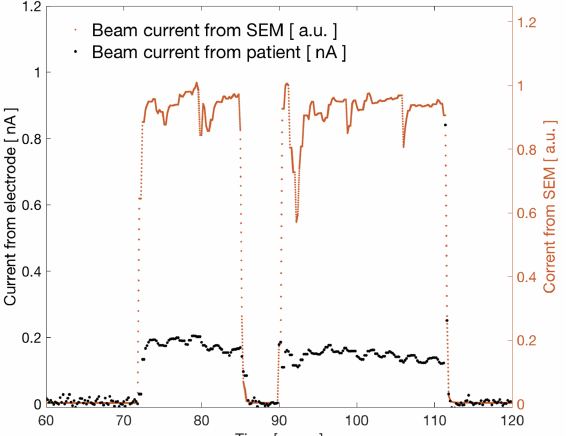
Figure 7. Proton beam signal (orange dots) measured by secondary electron monitoring (SEM) and the corresponding signal acquired by the electrode (black dots) positioned on the patient’s skin (see Figure 3). It is interesting to note that the sudden and unexpected beam stop during irradiation (at around second 85) and its next recovery (at around second 90) is perfectly followed by the electrode